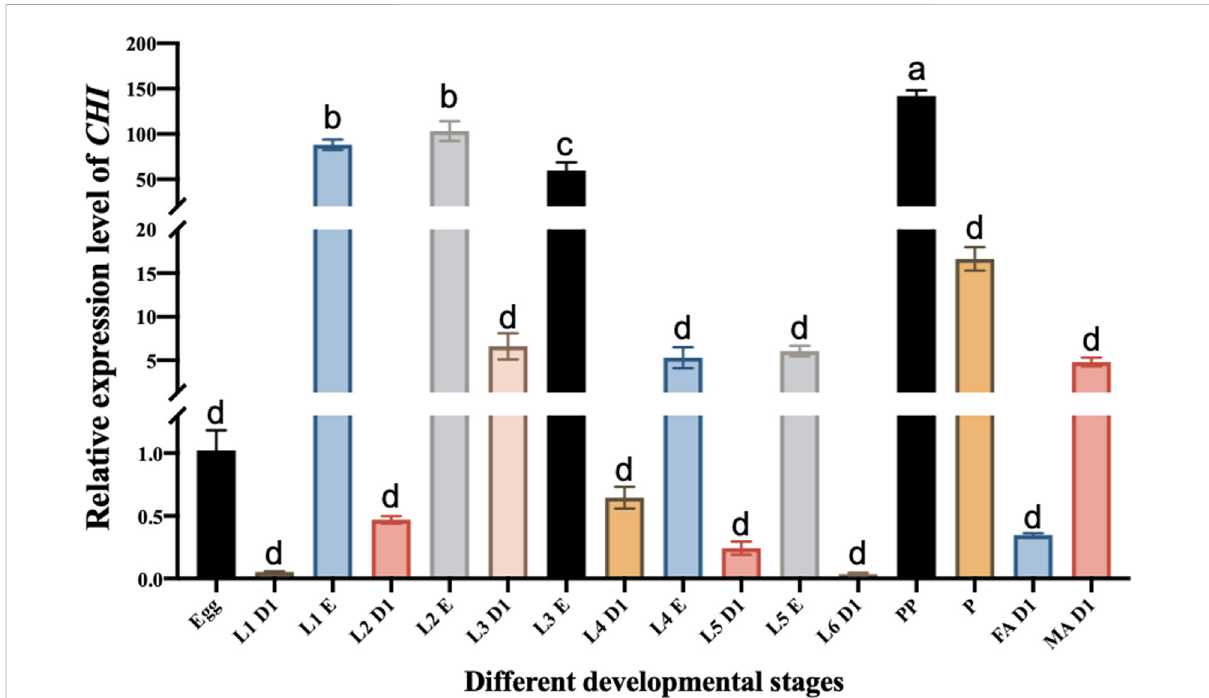
Changesintheexpressionlevelof CHI indifferentdevelopmentalstagesof Spodopterafrugiperda. L1D1,Larvaeatthe fi rstdayofthe fi rstinstar; L1E,Larvaeattheendofthe fi rstinstar;L2D1,Larvaeatthe fi rstdayofthesecondinstar;L2E, Larvaeattheend ofthesecond instar;L3D1,Larvaeat the fi rstday ofthethird instar;L3E, Larvaeattheend ofthethird instar;L4D1,Larvaeatthe fi rst dayofthefourth instar;L4 E, Larvaeattheend ofthe fourth instar; L5 D1, Larvae at the fi rst day of the fi fth instar; L5 E, Larvae at the end of the fi fth instar; L6 D1, Larvae at the fi rst day of the sixth instar; PP, prepupae; P, pupae; FA D1, Female adults at the fi rst day; MA D1, Male adults at the fi rst day. Three replicates were performed per group. (Mean ± SE; Tukey ’ s test; Different letters in the fi gure indicated signi fi cant differences between groups, p <